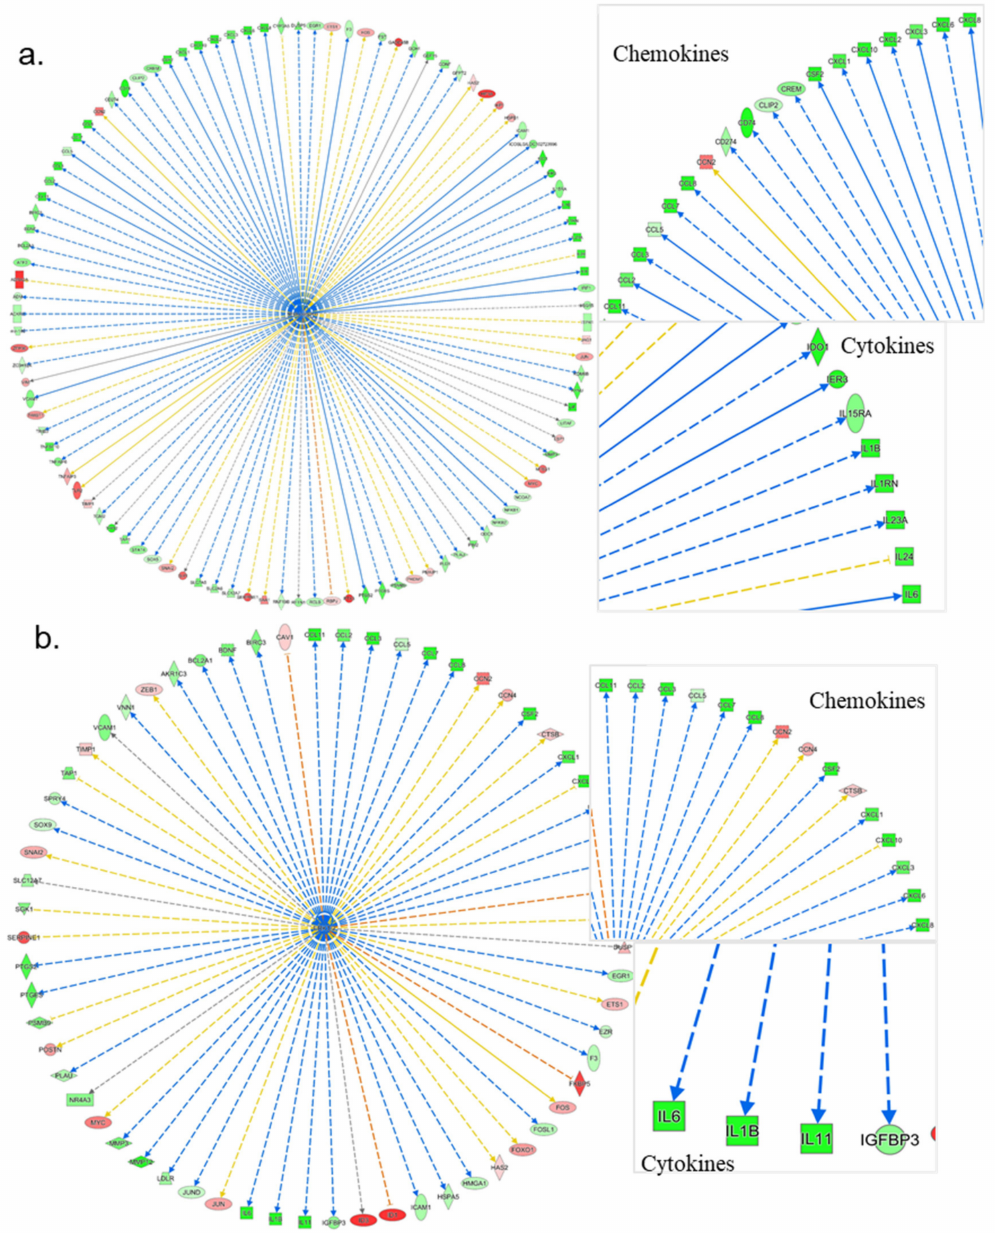
Figure 5. Ingenuity Pathways Analysis (IPA) showing upstream regulators for NF- κ B and ERK1 / 2 for VA vs. Ctr treatment group predicted to be inhibited. The predicted inhibition of these putative upstream regulators largely agrees with the observed downregulation of numerous chemokines and cytokines. ( a ) Upstream regulator network for an inhibited NF- κ B complex. ( b ) Upstream regulator network for an inhibited ERK1 / 2